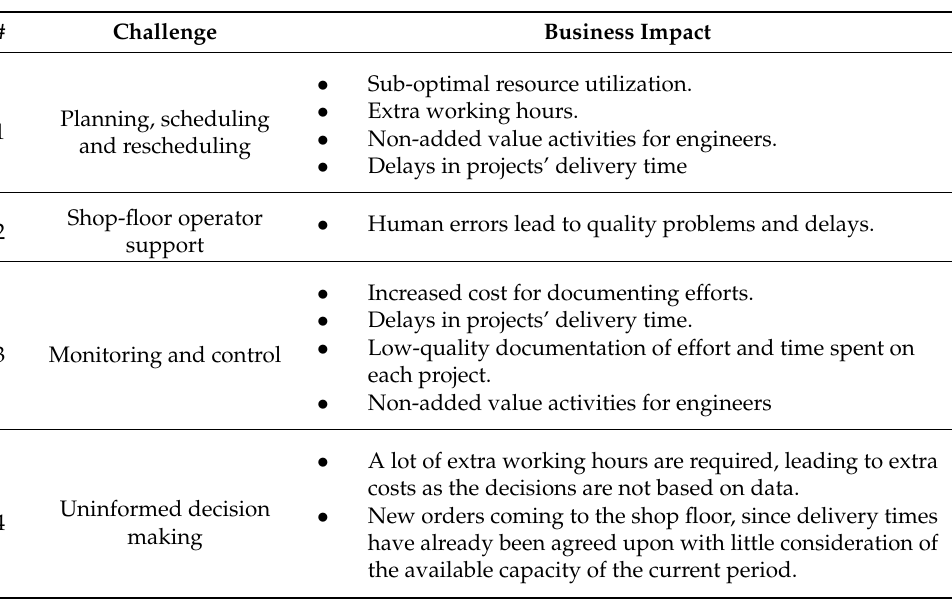
Table 1. Summary of main challenges and their impact on the business process.